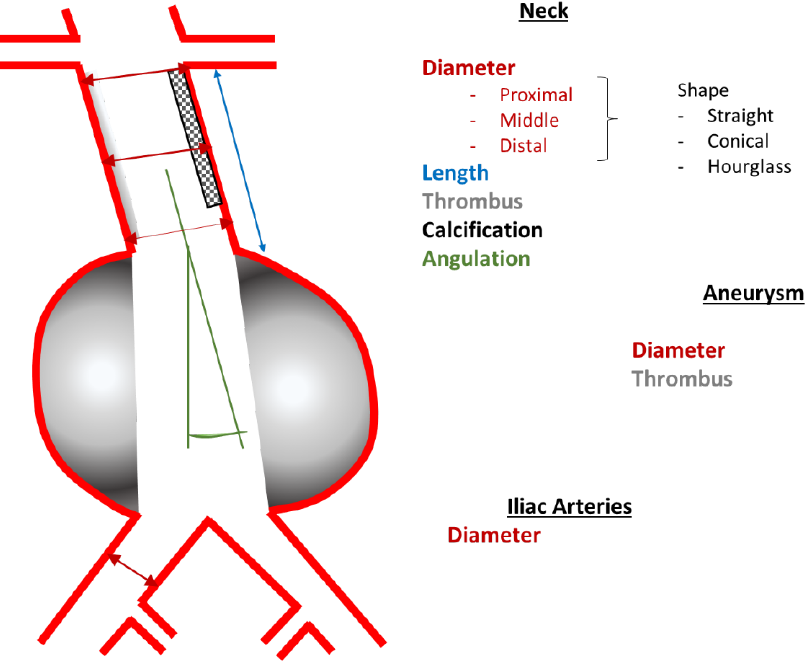
Figure 1. Parameters obtained from the three-dimensional imaging data.